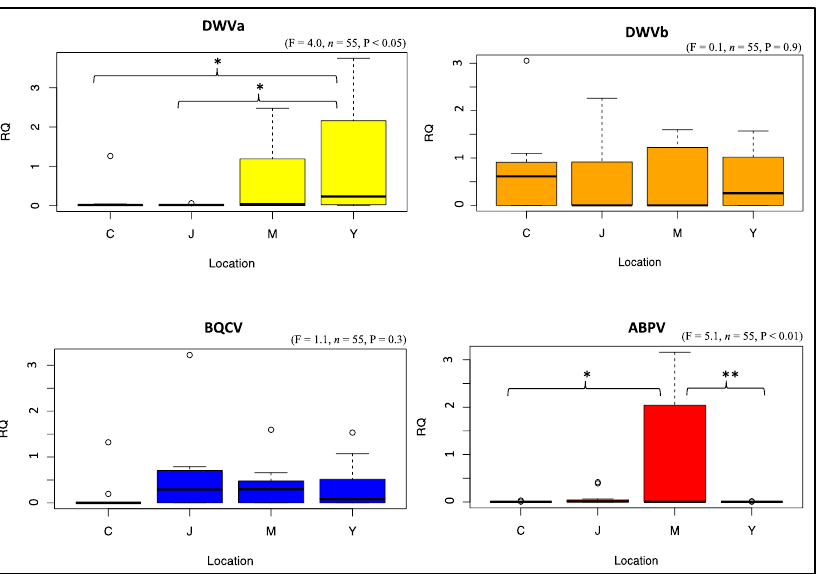
Figure 3. Relative quantification (RQ) of overtime viral infections of the studied colonies exposed by location. Abbreviation codes are (C) Chickasaw, (J) Jackson, (M) Milan, and (Y) Yum-Yum. The Boxplots (aka, Box and whisker Plots) summarize the data distribution based on minimum, first quartile, median, third quartile and maximum values. Viruses are: deformed wing virus type a and b (DWVa&b), black queen cell virus (BQCV) and acute bee paralysis virus (ABPV). ANOVA signification levels are * p < 0.05, ** p < 0.01.